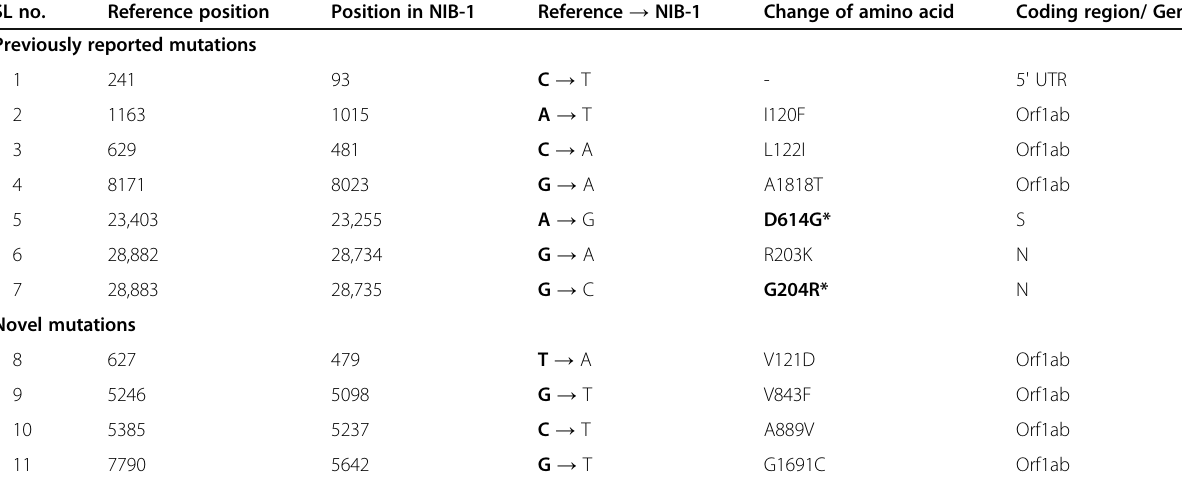
Table 1 Mutations in SARS-CoV-2 NIB-1 SL